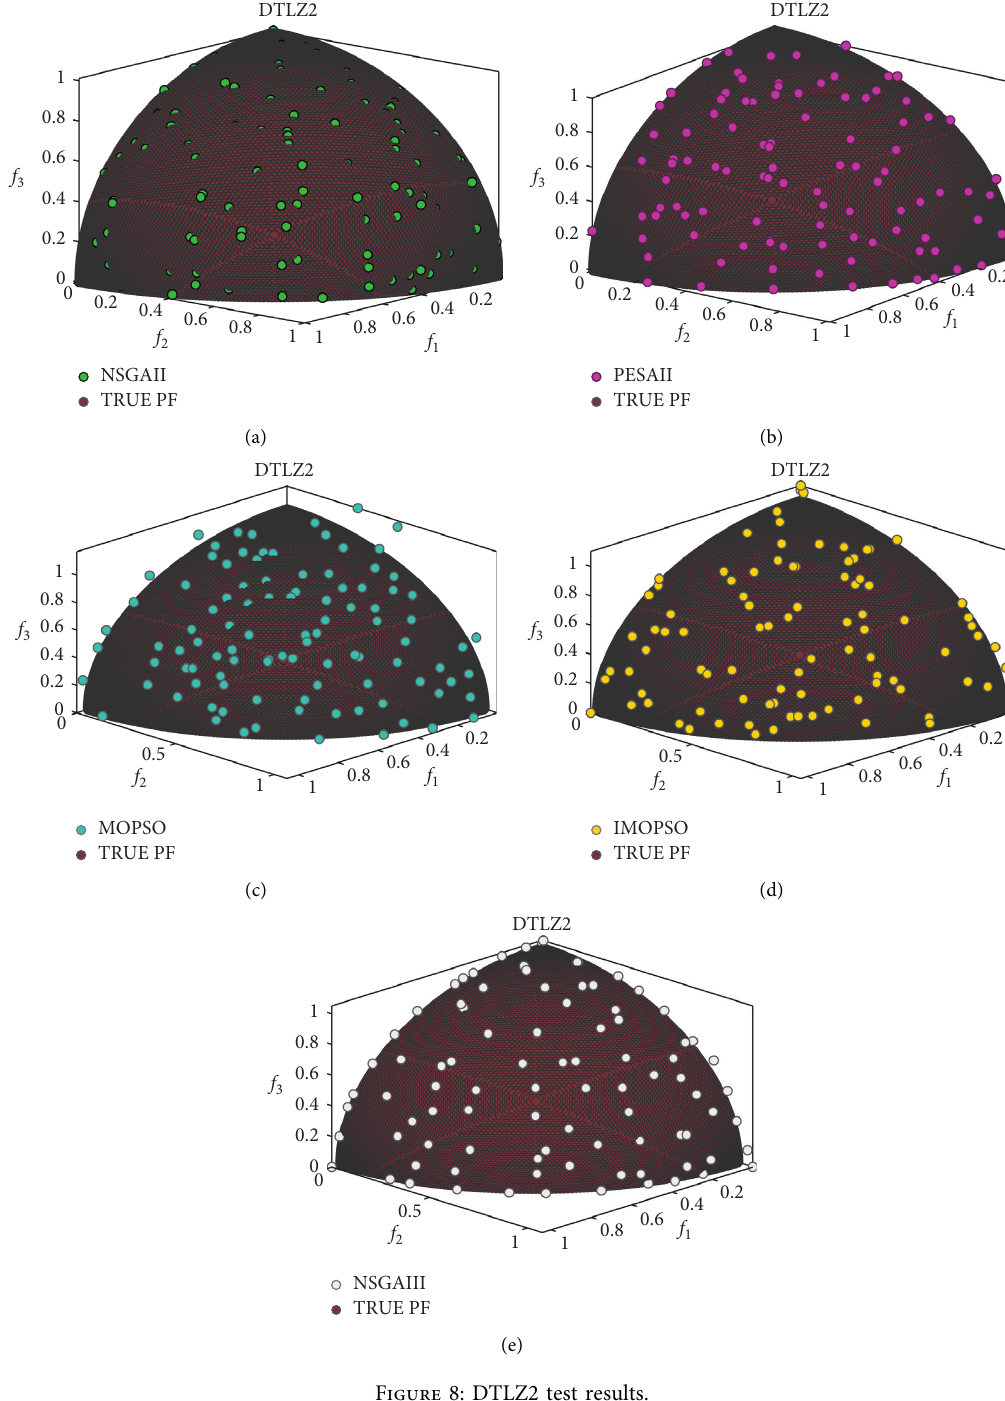
Figure 8: DTLZ2 test